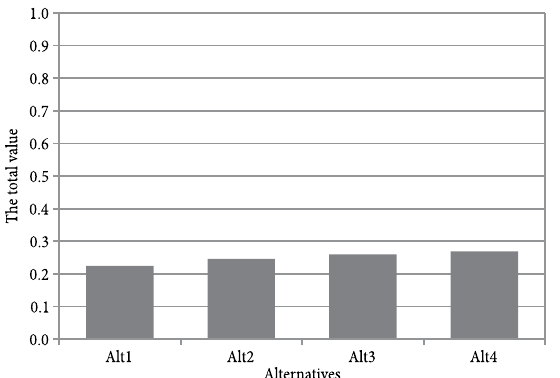
Fig. 6. Resulting graph of the nested model